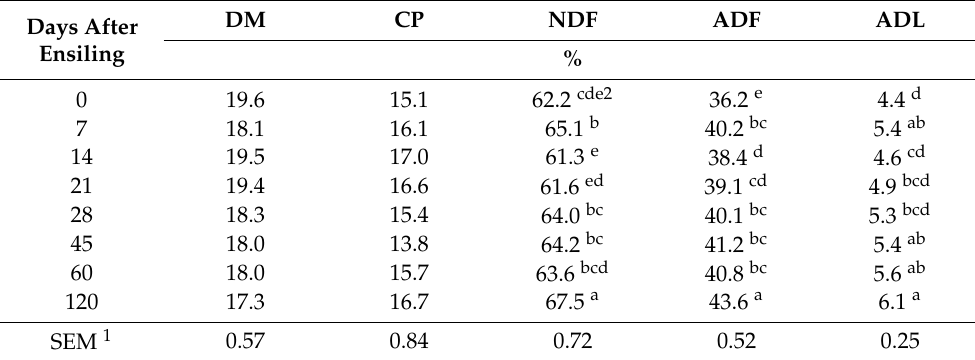
Table 3. Dry matter (DM), crude protein (CP), neutral detergent fiber (NDF), acid detergent fiber (ADF), and lignin concentrations of annual ryegrass + oat + crimson clover (ROC) mixture (Study 3) ensiled for 120